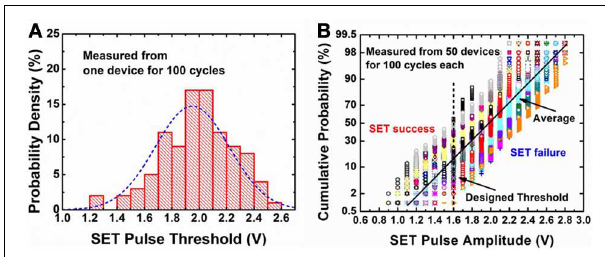
post-synaptic backward spike is designed to be a short two-phase pulse with a small negative pulse (e.g., − 0.8V/10ns) followed by a large positive pulse (e.g., + 1.9V/10ns). If both the input layer neuron and the output layer neuron fire, the synapse faces an actual SET programming pulse (e.g., + 1.6V/10ns); if only the output layer neuron fires, the synapse faces an actual RESET programming pulse (e.g., − 1.9V/10ns). Thus, the synapse conductance map between the input layer and the output layer tends to mimic the input pattern light